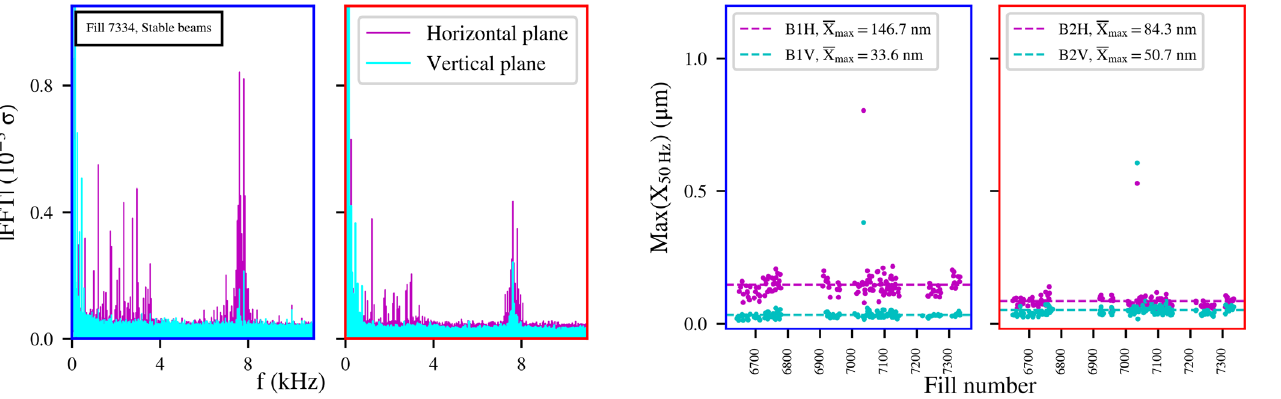
(right) frequency cluster and for the Fills 7033 (top) and 7035 (bottom) with the standard ADT bandwidth and extended bandwidth, respectively. Comparing the two spectra yields an increase in the amplitude of the 50 Hz